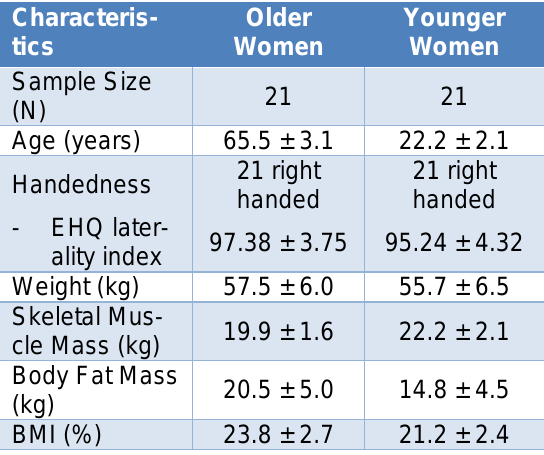
Table 1: Demographics of the participants